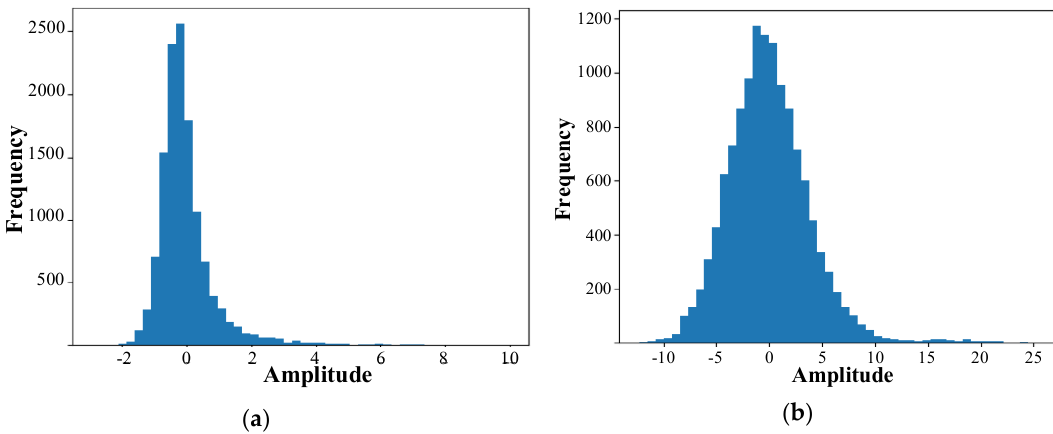
Figure 2. Left picture ( a ) is the network’s output distribution after the traditional training process, the right figure ( b ) shows the output distribution with the BN constraint.